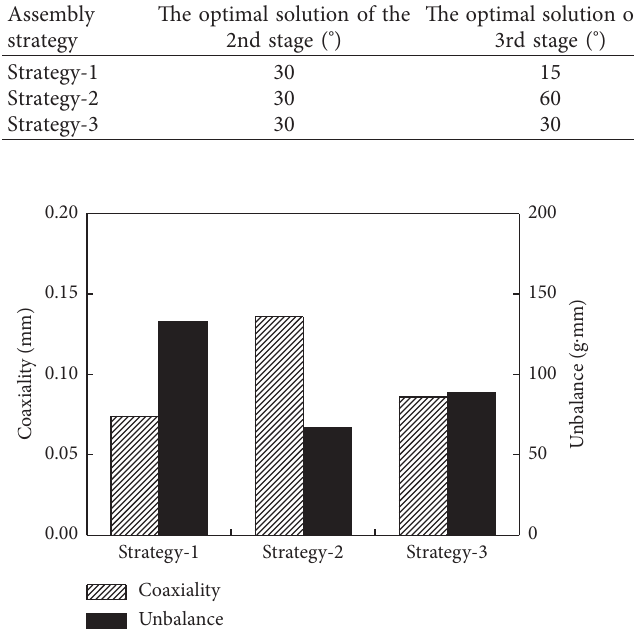
Figure 13: The histogram of the experimental results.